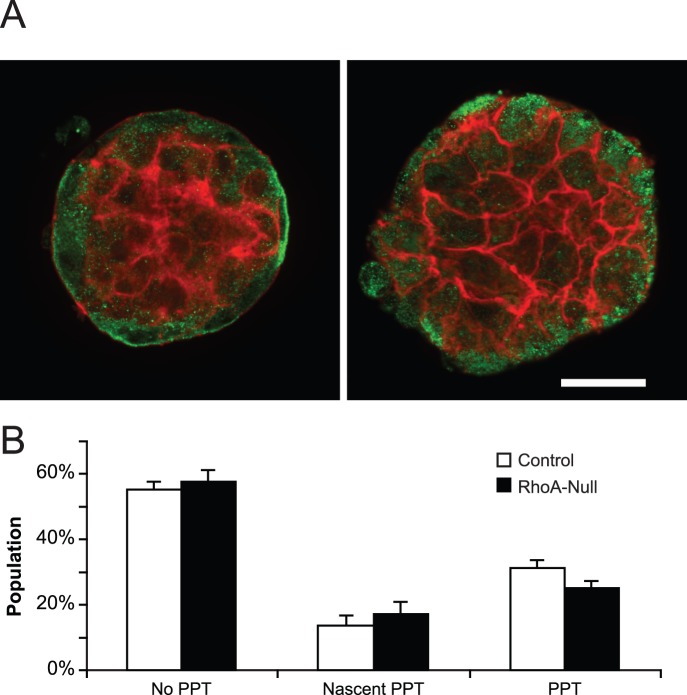
Microscopy shows that RhoA-null megakaryocytes have normal cytoskeleton architecture and do not increase proplatelet number.(A) Shown are representative laser confocal images of megakaryocytes (control and RhoA-null, left and right respectively) stained for β1-tubulin (antibody, green) and F-actin (phalloidin, red). Magnification is 63× and the scale bar is 20 um. (B) Megakaryocytes were imaged by phase contrast microscopy, and they were characterized on the basis of exhibiting proplatelets, nascent proplatelets (∼ <2 um), or no proplatelets. Mean ±SE is shown. N = 3.